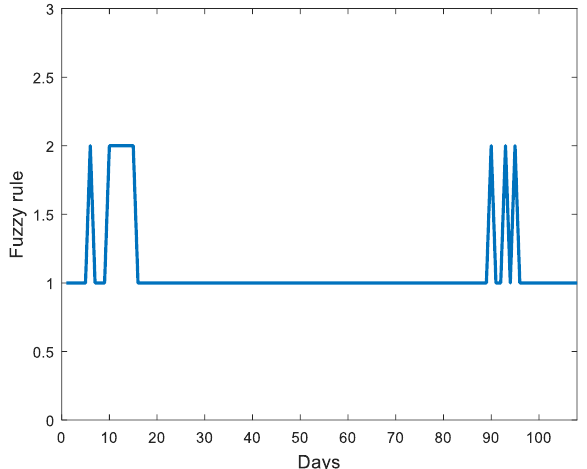
Figure 8. Fuzzy rule evolution of kurtosis feature.